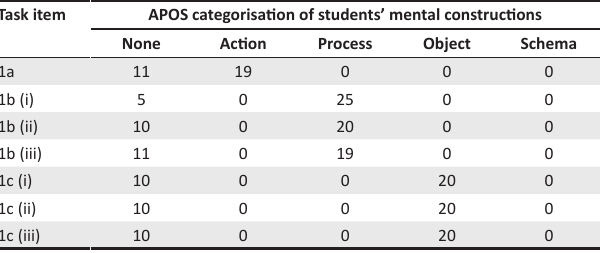
TABLE 2: Complete summary of the categorisation of students’ mental construction, according to APOS, on each of the test items on limit of series. Task item